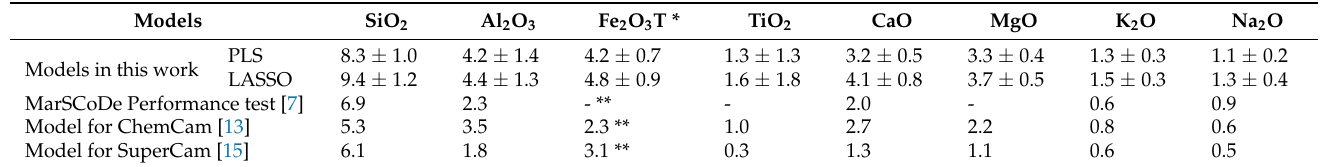
Table 1. The average RMSE (wt.%) of the 50 PLS and 50 LASSO models, and RMSEs of published models for MarSCoDe, ChemCam, and